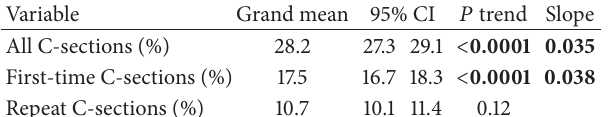
Table 4: Caesarean section rates for women giving birth in Maine,